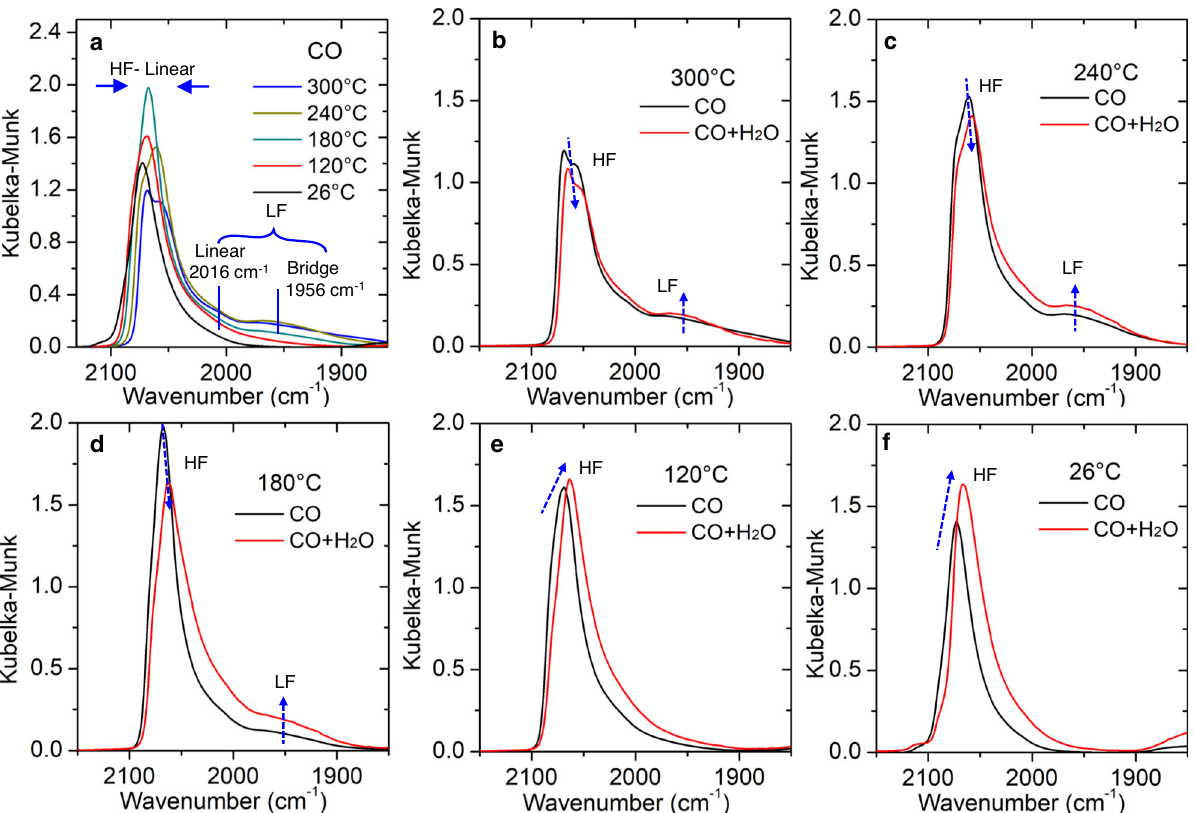
Fig. 3 DRIFTS studies of CO bonds on Pt nanoclusters under CO and WGS conditions. The experiments were performed by decreasing the temperature from high to low. a The temperature-dependent CO – DRIFTS spectra of Pt/CeO 2 catalyst collected in the ramp-down process. Bands in high frequency (HF) region (2072 – 2054cm − 1 ) are assigned to linearly adsorbed CO on terrace or step Pt sites 18,22,53,54 . In low frequency (LF) region, the band centered at ~2016 cm − 1 is assigned to CO linearly adsorbed on perimeter Pt sites while the band centered at ~1956 cm − 1 is assigned to a bridged CO adsorption at the metal support interface 18 – 24 . b – f At 300 °C, 240 °C, 180 °C, 120 °C, and 26 °C, the changes of CO bands on the Pt surface sites upon the change of condition from CO to WGS. The positions of HF peaks were labeled in Supplementary Fig. 6.